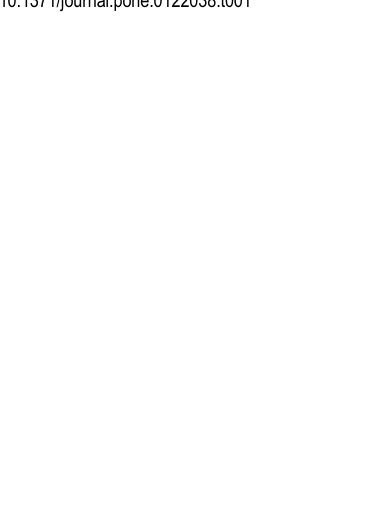
* Specimens had damaged morphological structures essential for identi fi